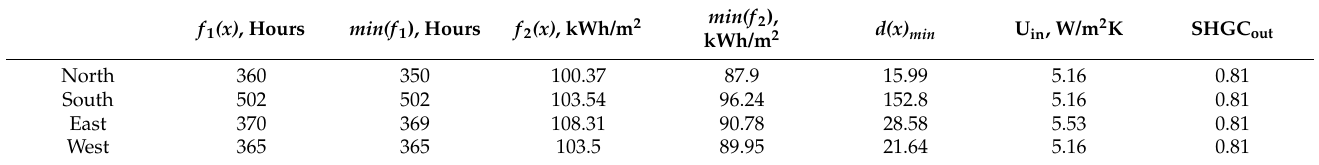
Table 7. Summary of numerical outcomes for the optimal solutions—Darwin.